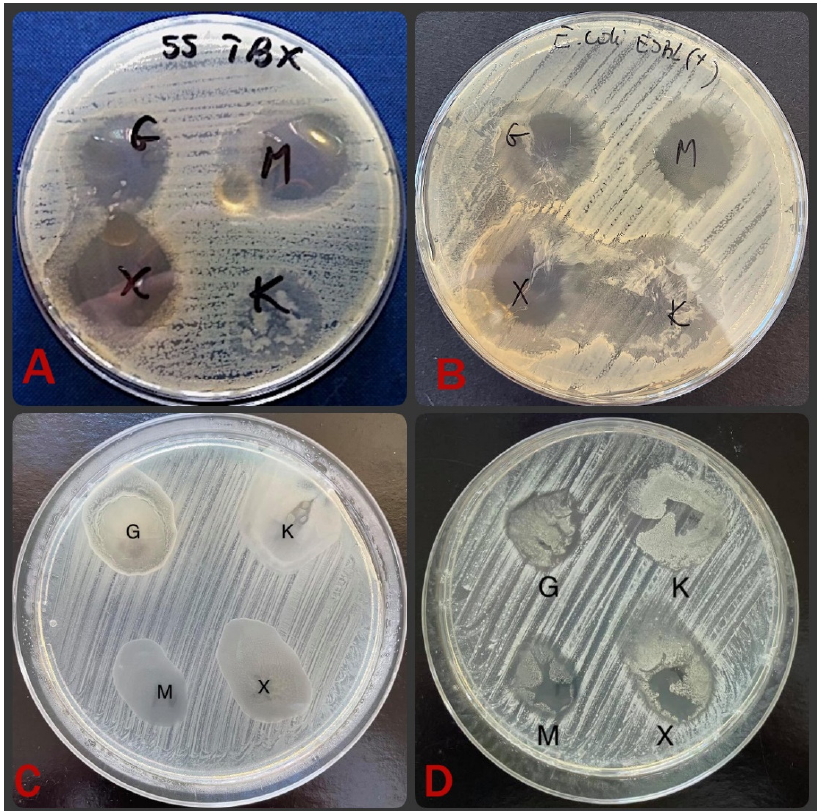
Figure 5. Activity of Ag-glucose (G), Ag-maltose (M), Ag-xylose (X) foils compared with control foil Materials 2022 , 15 , 1269 with sole alginate (K) against E. coli ( A ), ESBL-positive bacteria ( B ), S. aureus ( C ) and MRSA ( D ). Table 2. Percentage (%) of bacterial isolates, whose growth was inhibited by the AgNPs.